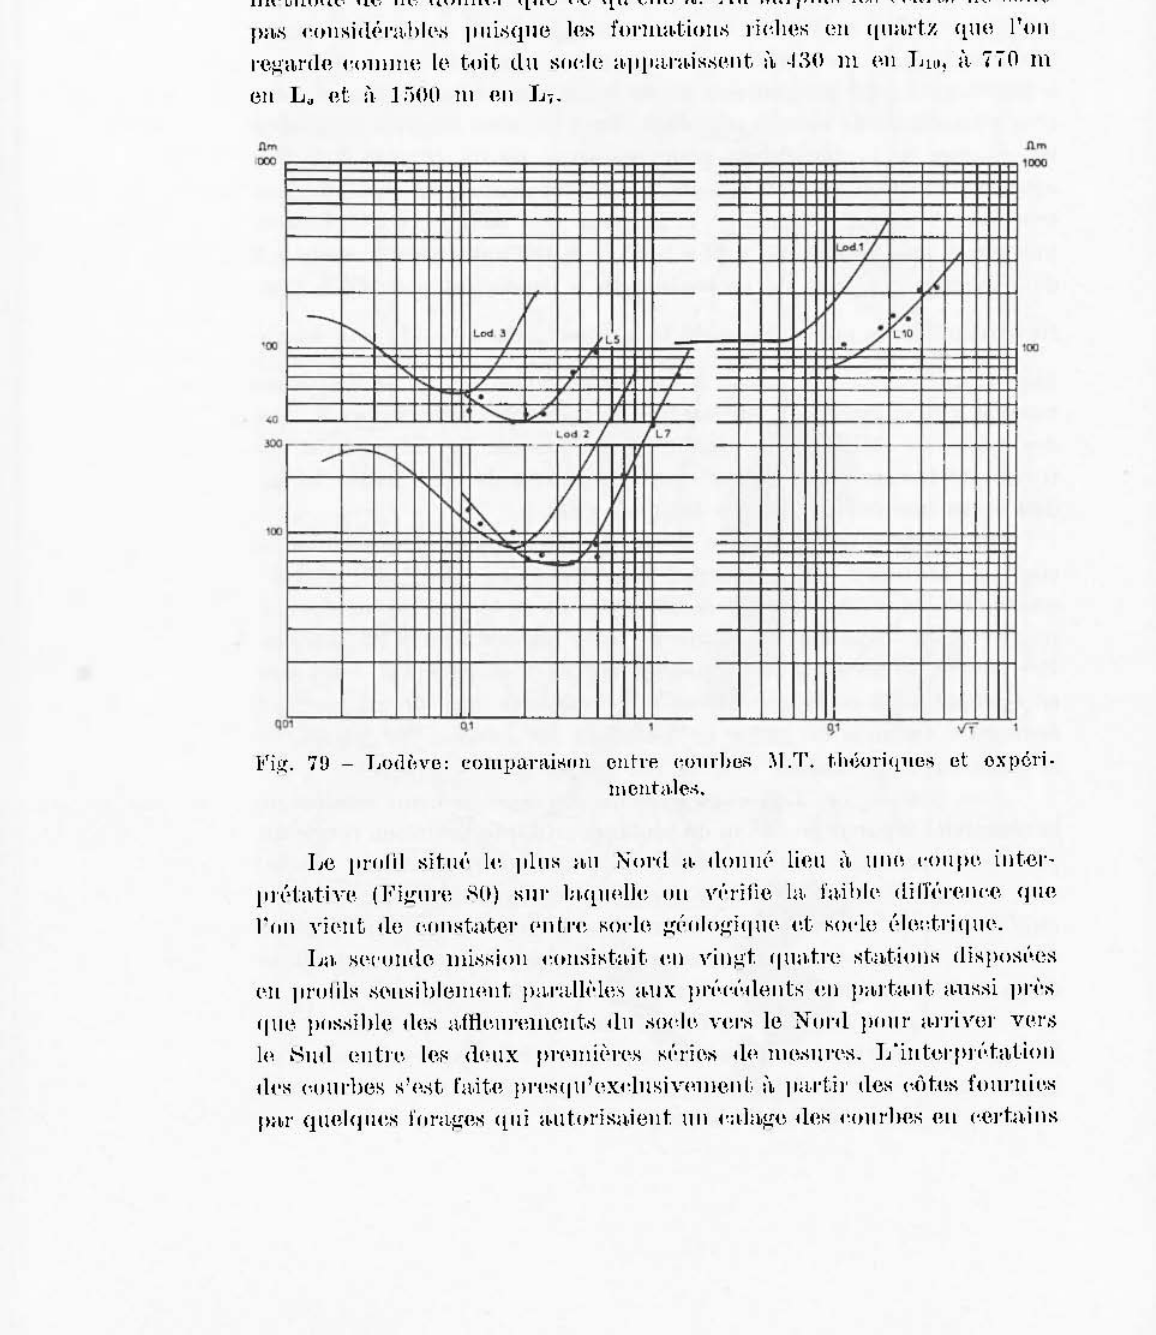
.. , , , " Fi~. 7!.l - Lodiwe: eOlllparaiKlln cntrp ('01lrhefl ~l.T. t.hÙori(llles et expéri. lllcntij.le.~. l,e pl"olil Hitlli' le ]lluH ali NOI'([ ;~ ([OH Hl' liell Ù, UIW l'Ollpil illt.el·· pl"l,t:ative (Figure SO) H1I1' hl[lIl\lk 1)11 \'('I"ilie b. j"n.ibl{· ([il1"I'I·el](".e